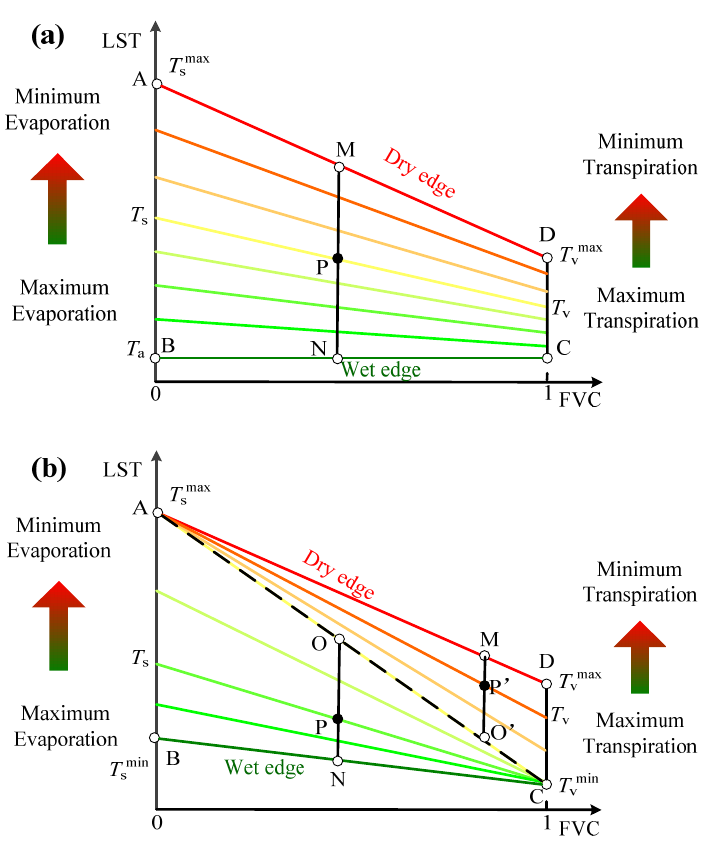
Figure 1. ( a ) the conventional trapezoidal LST/FVC space derived from [17]; ( b ) the two-stage trapezoidal LST/FVC space.